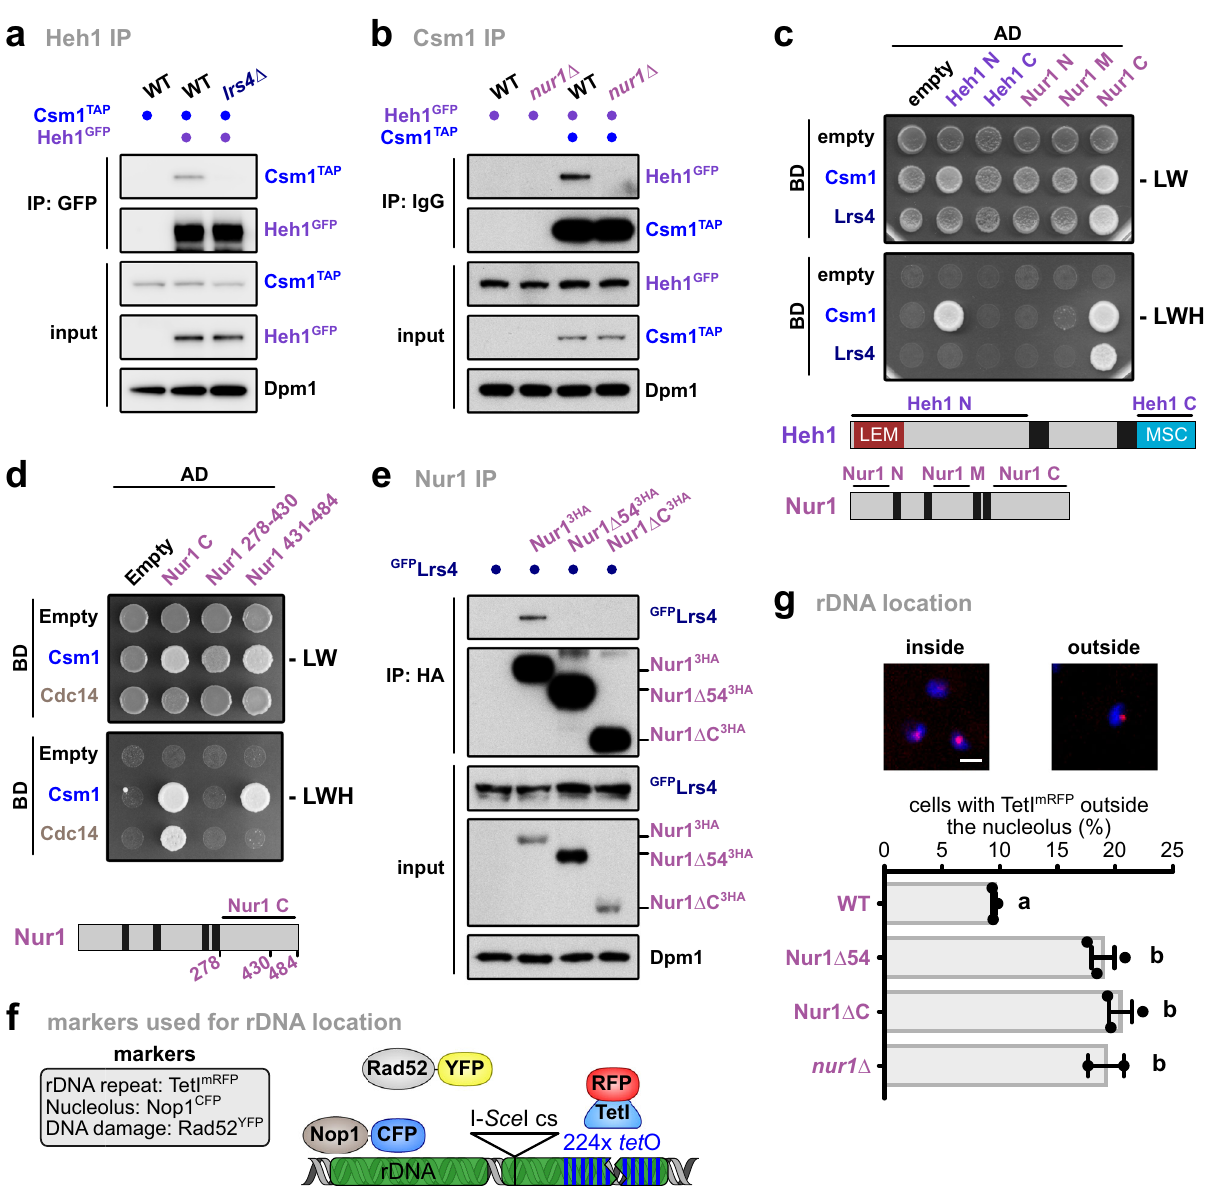
Fig. 2 The Nur1 C-terminus is critical for CLIP-cohibin interaction. Co-immunoprecipitation of Csm1 TAP and Heh1 GFP in WT, lrs4 Δ ( a ) and nur1 Δ ( b ) cells. Dpm1 served as loading control. Y2H analysis of Csm1 and Lrs4 with Heh1 and Nur1 nucleoplasmic domains ( c ); or of Csm1 and Cdc14 with Nur1 C and truncations ( d ). Fusions with Gal4-activating domain (AD) or Gal4-DNA-binding domain (BD) are indicated. Scheme of the constructs used for CLIP complex components is shown. e Co-immunoprecipitation of GFP Lrs4 with either HA-tagged Nur1 full-length (Nur1 3HA ), lacking its last 54 residues (Nur1 Δ 54 3HA ) or the complete C-terminal domain (Nur1 Δ C 3HA ). Dpm1 served as loading control. f Scheme of rDNA locus and fl uorescent markers used in g . Cells bear a tetO array adjacent to an I- Sce I endonuclease cut site inserted into an rDNA unit on chromosome XII, which is revealed by TetI mRFP foci. These cells also express Rad52 YFP as a marker of the HR machinery. The nucleolus is visualized by a plasmid expressing the nucleolar protein Nop1 ECFP . g Percentage of undamaged Nur1 6HA , Nur1 Δ 54 6HA , Nur1 Δ C 6HA , or nur1 Δ cells with rDNA repeats localized outside the nucleolus. Repeat location was monitored by the position of TetI mRFP focus relative to the nucleolar mark, and quanti fi cation and representative images are shown. Data are mean ± SEM of n = 3 independent biological replicates or n = 2 for nur1 Δ . Scale bar, 2 µ m. Statistical analysis was performed using analysis of variance (ANOVA),